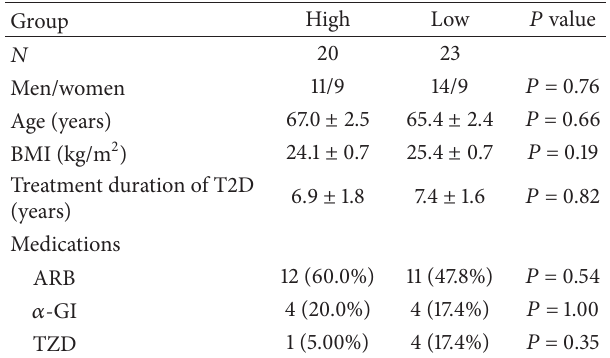
Table 3: Patient profiles partitioned by the cutoff value of UAGTCR before treatments.